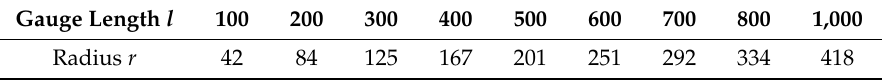
Table 2. Maximum radius of timber column using different gauge length of FBG sensors (Unit: mm). Gauge Length l